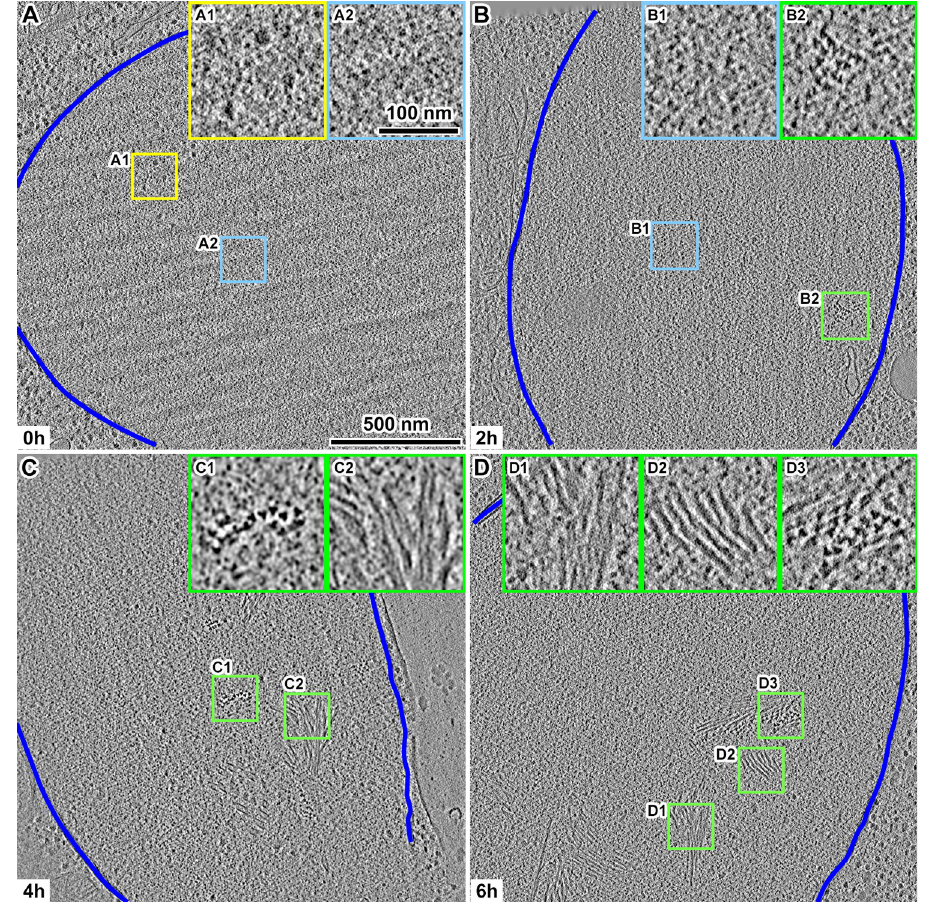
Fig 2. Visualization of meiotic triple helix (MTH) bundles using cryo-ET. Volta cryotomographic slices (10 nm; computational) of WT cell nuclei (A) before meiosis and after (B) 2 hours, (C) 4 hours, and (D) 6 hours in SM. The boxed areas are enlarged 3-fold in the corresponding insets. Inset A1 shows 3 megacomplexes. Insets A2 and B1 show nucleosome-like particles. Insets B2, C1, and D3 show bundles of MTHs presenting a trefoil motif. Insets C2, D1, and D2 show side views of bundles of MTHs. The nuclear envelopes are delineated with the dark blue lines.